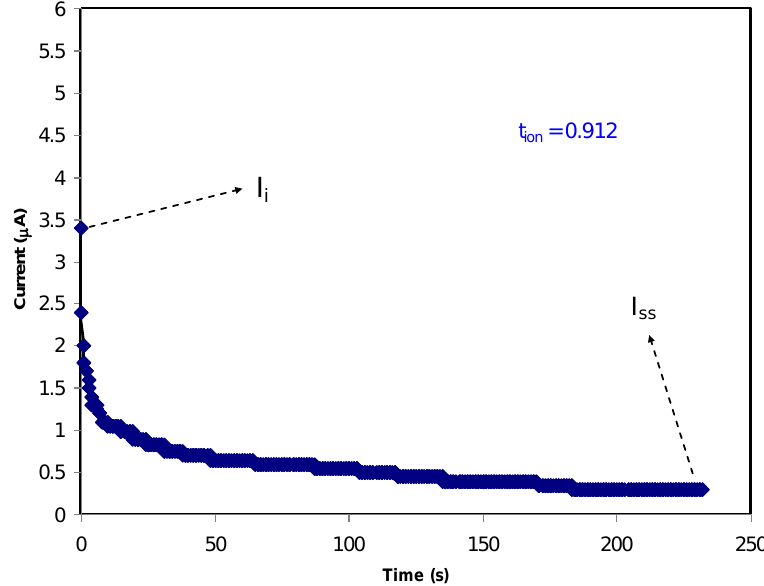
Figure 3. Current versus time for the PMNG-3 system.